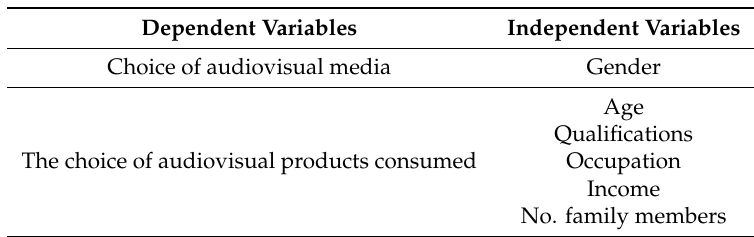
Table 1. Analyzed